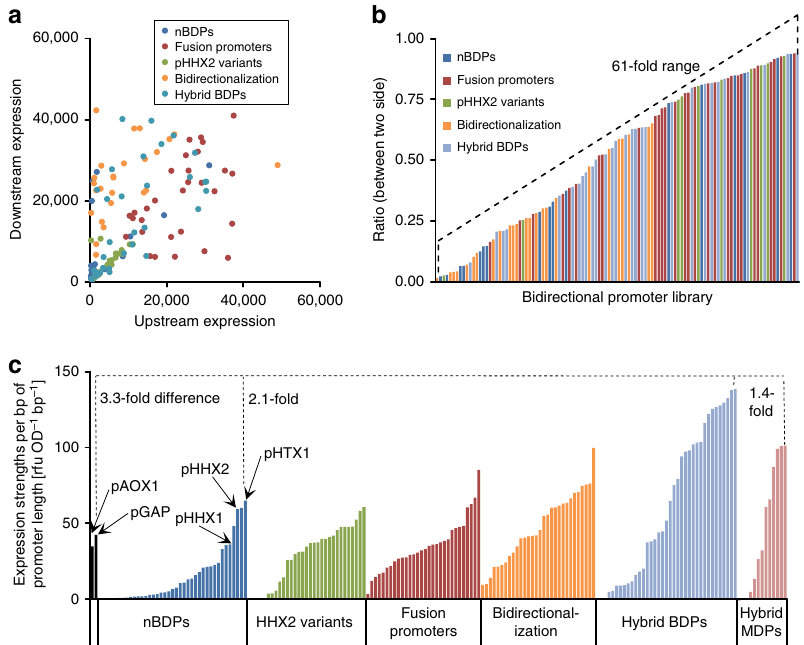
Fig. 5 The library of 168 BDPs provides different absolute expression strengths, ratios, and regulatory pro fi les with synthetic BDPs (sBDPs) considerably surpassing the expression strength per bp of promoter length of natural BDPs (nBDPs). a The library of BDPs covers the whole expression space. Normalized upstream and downstream reporter fl uorescence is shown (rfu OD − 1 as in Fig. 1 to Fig. 4; under optimal growth conditions, by the